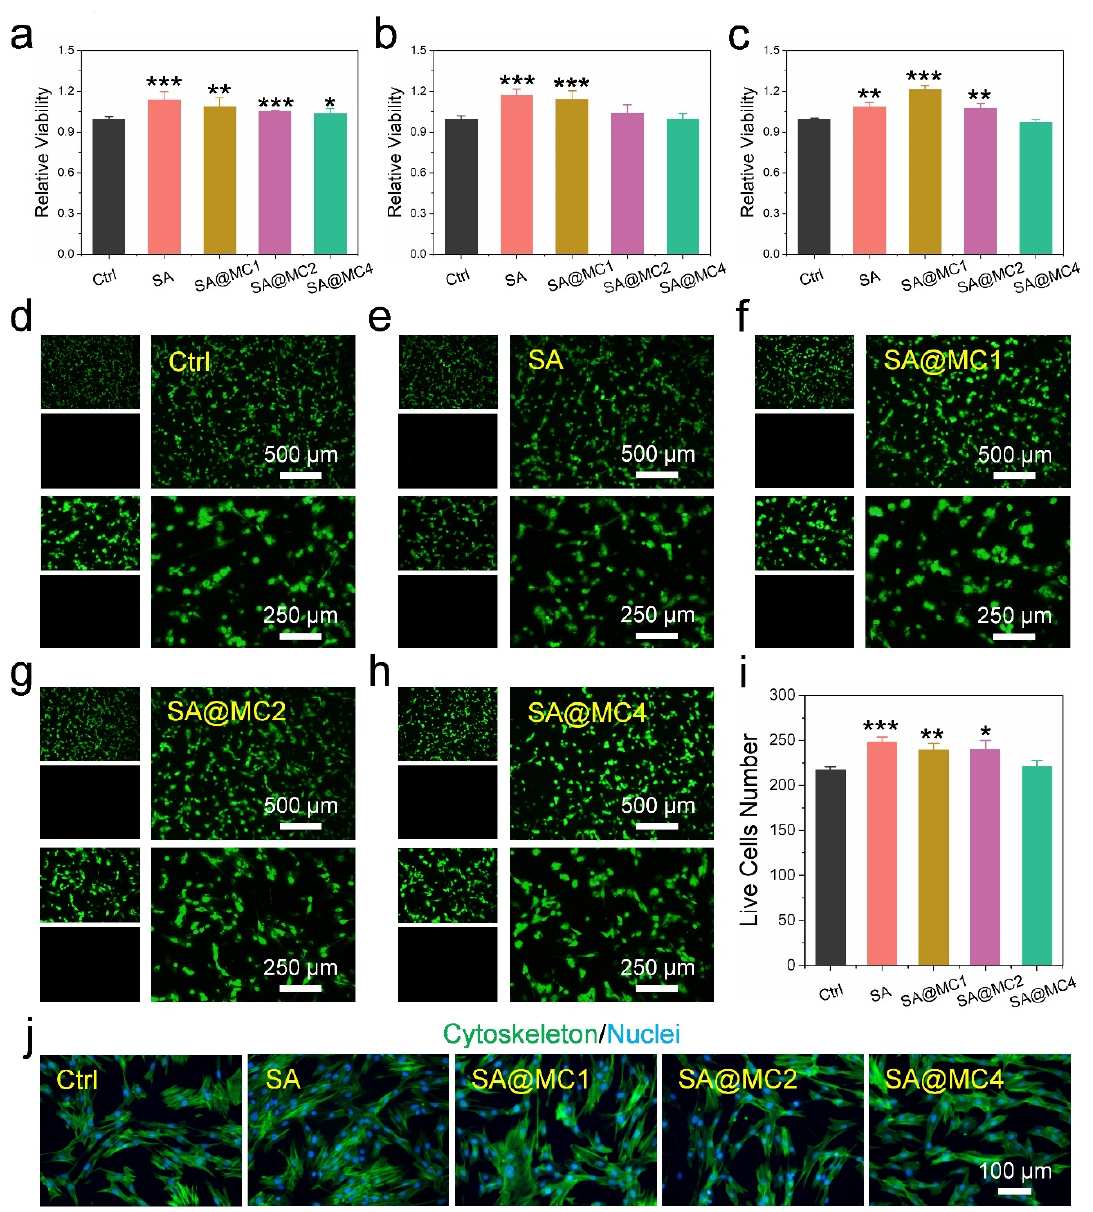
Figure 4. Biocompatibility assessment of SA@MC injectable hydrogels. ( a – c ) Cell viability of HDFs cocultured with the extracts from SA@MC injectable hydrogels at different concentrations of MC after different times; ( d – h ) live/dead staining of HDFs cocultured with the extracts from SA@MC injectable hydrogels at different concentrations of MC after 24 h; ( i ) live cell number statistics; ( j ) cytoskeleton/nuclei staining of HDFs cocultured with the extracts from SA@MC injectable hydrogels at different concentrations of MC after 24 h. * p < 0.05, ** p < 0.01, and *** p < 0.001 vs. the control group.